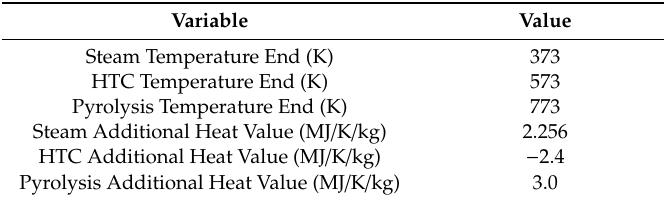
Table 3. Dependent variables of the energy demand example simulation.